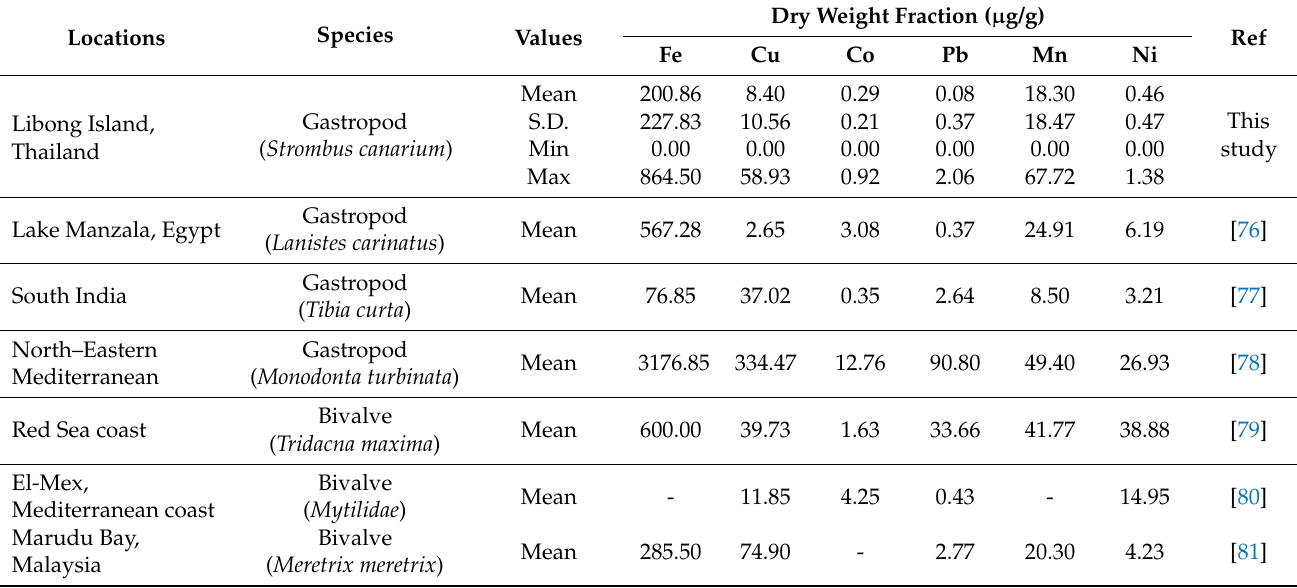
Table 4. Concentration of trace metals in Strombus canarium and comparison to other localities